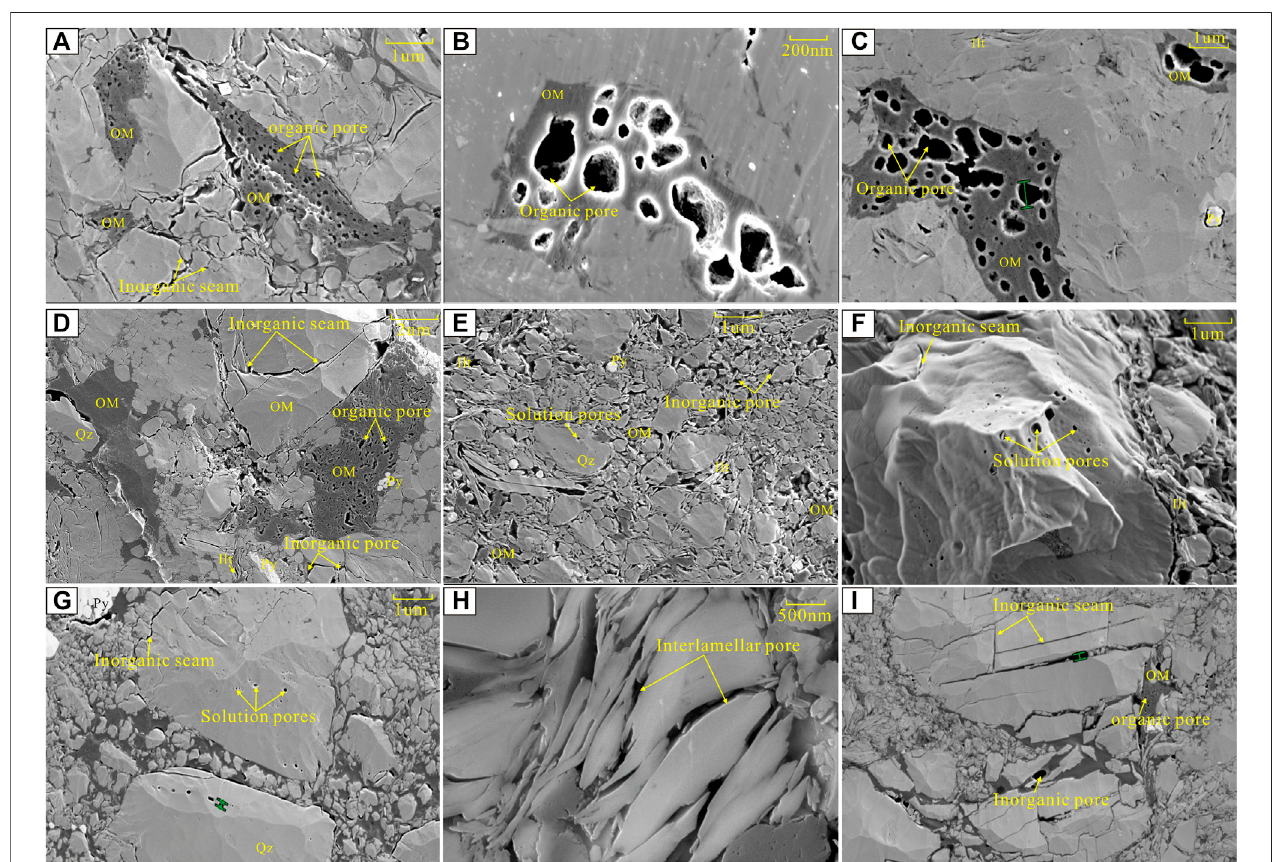
FIGURE 5 | Types of microscopic pore spaces in the shales of the Wufeng-Longmaxi Formation in southern Sichuan. (A) Well L205; organic matter pores: 4028.52 – 4028.66 m. (B) WellL205;organicmatterpores;4033.82 – 4033.86 m. (C) WellL203;organicmatterhole;3802.15 – 3802.20 m. (D) WellL207;organicholes, inorganic fractures; 3548.22 – 3458.31 m. (E) Well L207; dissolved pores, intercrystalline pores; 3456.34 – 3456.37 m. (F) Well L207: dissolution hole; 3432.58 – 3432.62 m. (G) Well L207: dissolution hole; 3432.58 – 3432.62 m. (H) Well L207: Holes between clay slices; 3453.66 – 3453.69 m. (I) Well L203; mesh fracture; 3804.44 – 3804.52